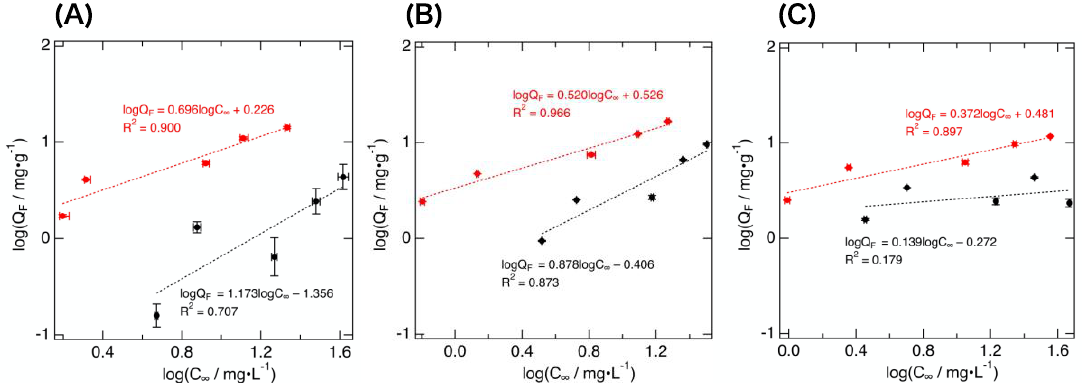
Figure 4. Adsorption isotherms of the prepared adsorbents and the mesoporous carbons: MJ(4)010 ( A ), MJ(4)030 ( B ), and MJ(4)150 ( C ). The red and the black markers indicate the data obtained for the ZrO 2 · xH 2 O / mesoporous carbons and the unmodified mesoporous carbons, respectively. Equations of the Freundlich isotherm are also shown.